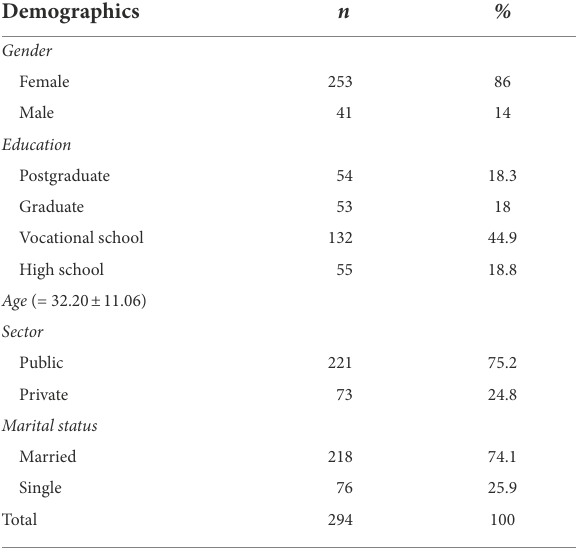
TABLE 1 Demographic characteristics of the sample ( n =